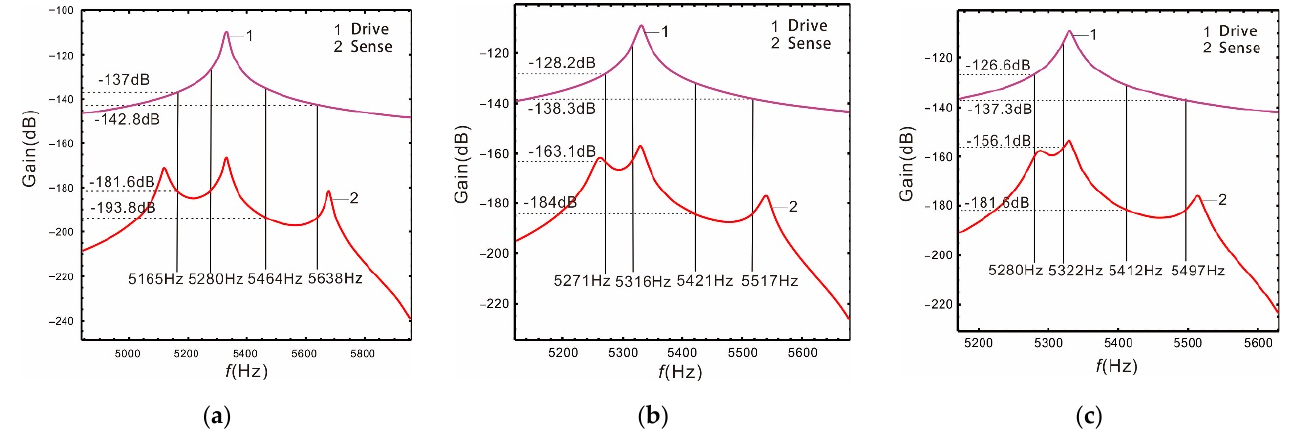
Figure 4. Linear case: the resonant frequency of the drive mode close to the low-order resonant frequency of the sense mode: ( a ) ∆ = 560Hz; ( b ) ∆ = 280Hz; ( c ) ∆ =